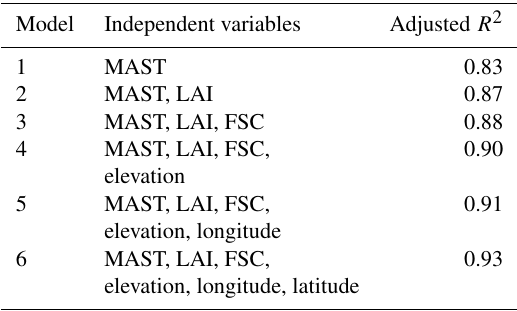
Table 2. The statistics of the stepwise linear regression